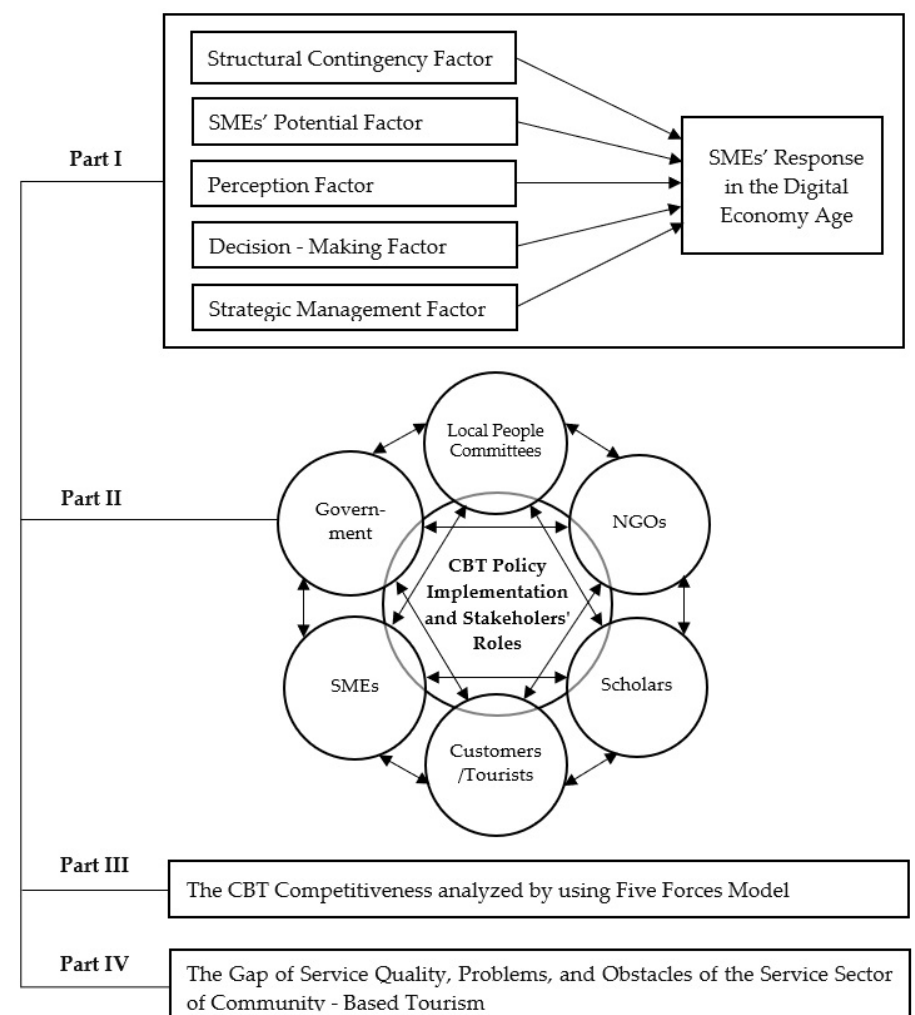
Figure 1. Conceptual framework of the study.